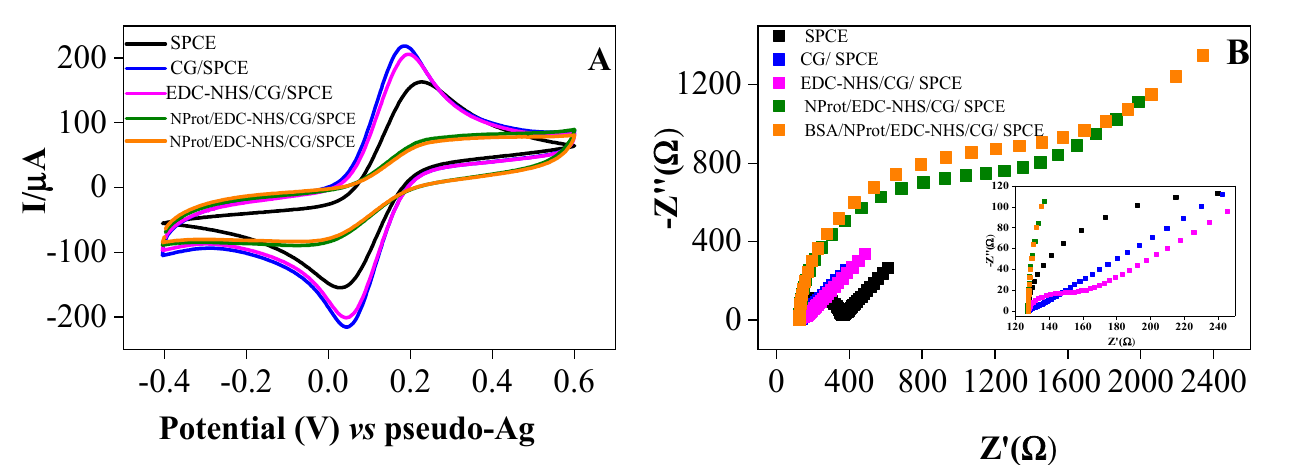
Figure 1. ( A ) Cyclic voltammograms and ( B ) EIS measurements of bare SPCE (black), CG/SPCE (blue), EDC-NHS/CG/SPCE (magenta), N protein/EDC-NHS/CG/SPCE (green), and BSA/N protein/EDC-NHS/CG/SPCE (orange), in 5 mmol L − 1 [Fe(CN) 6 ] 3 − /4 − + 0.1 mol L − 1 KCl.